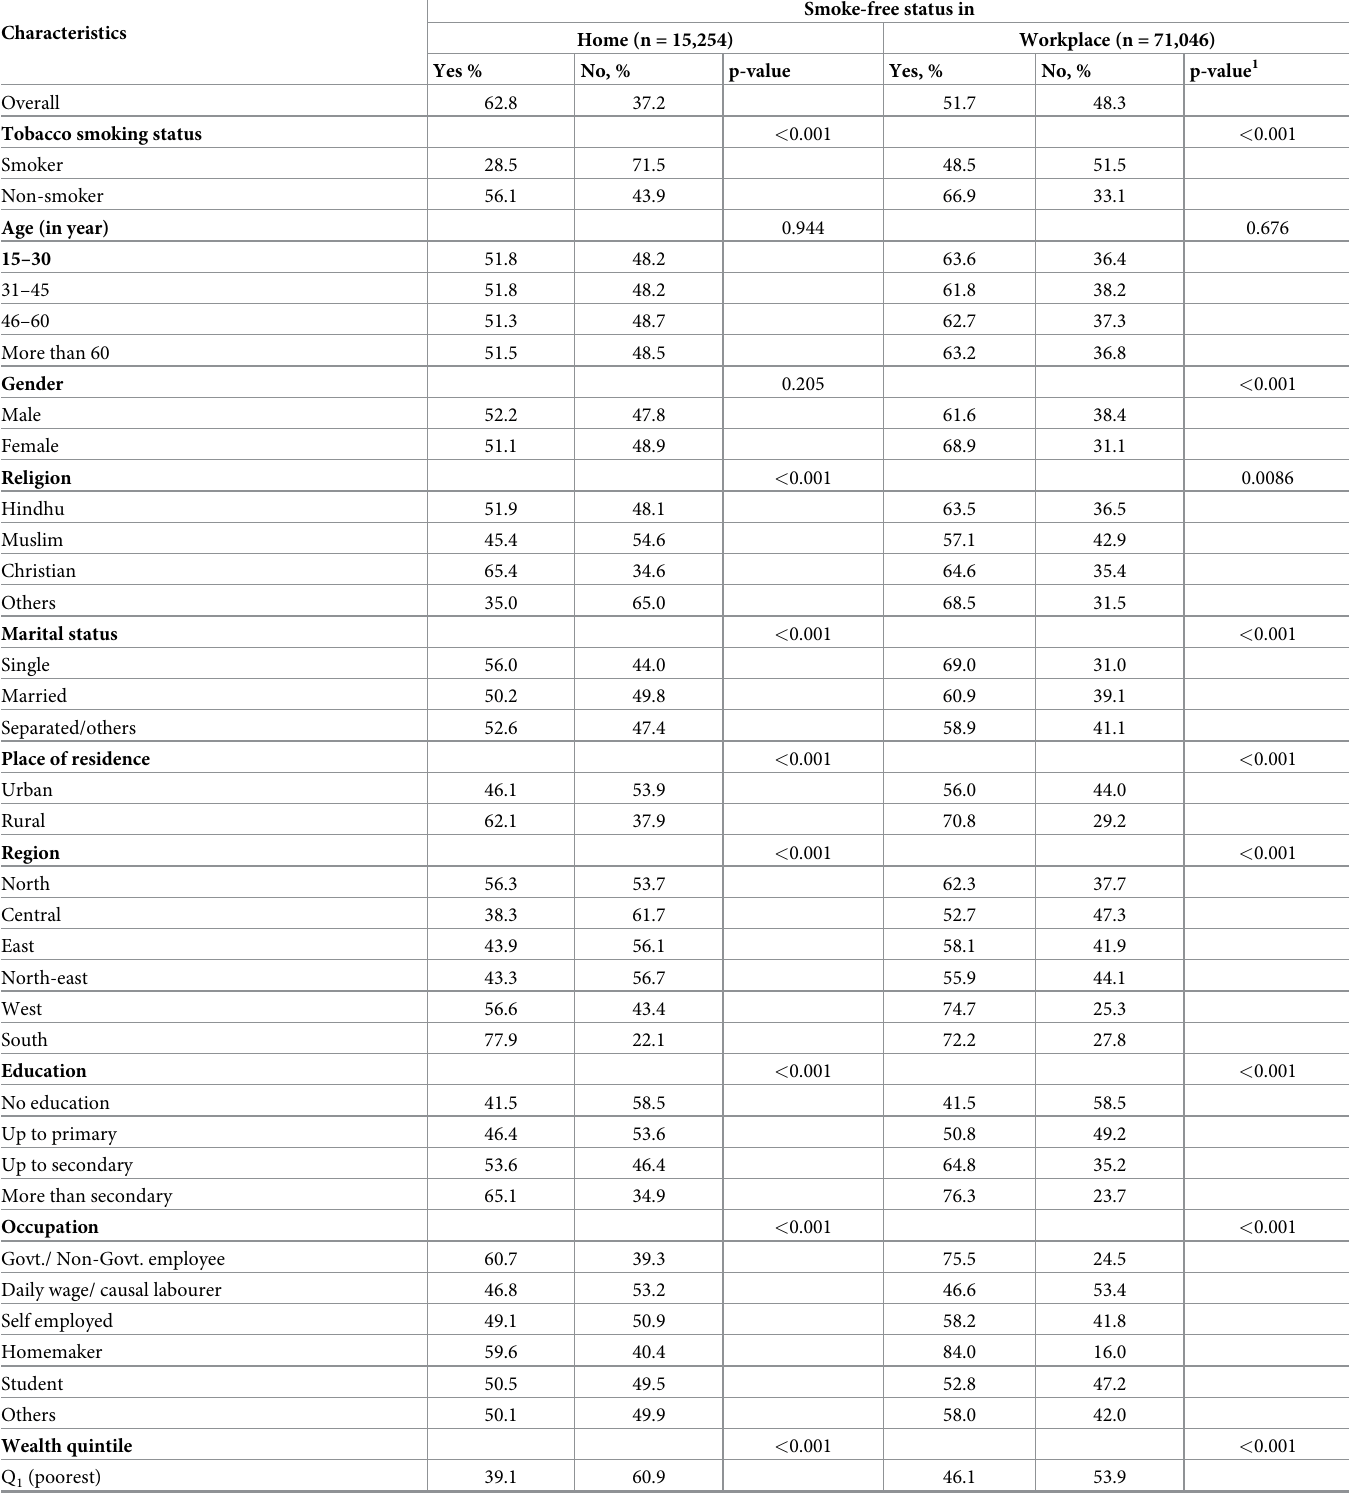
Table 2. Correlates of smoke-free status of homes and workplaces in India.